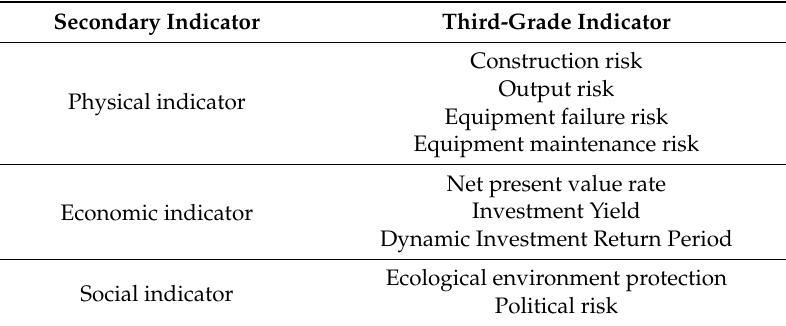
Table 1. Risk indicators